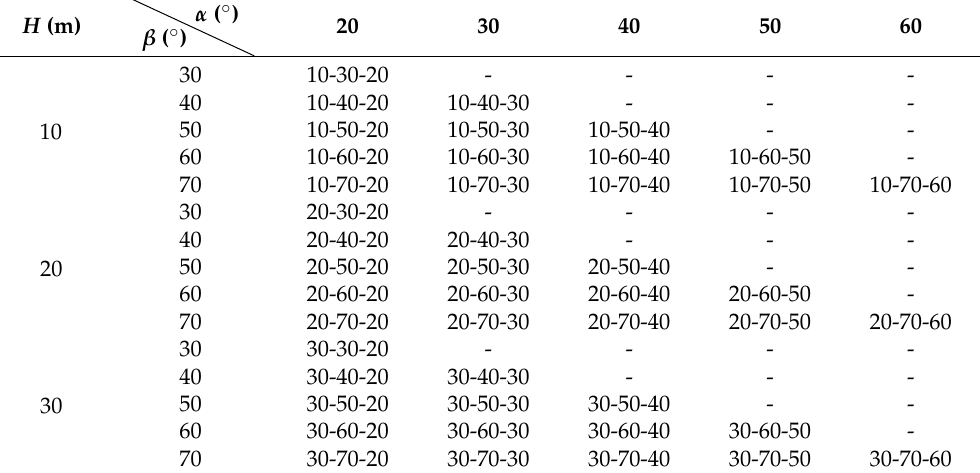
Table 2. Geometric parameters of the ridge slope model.